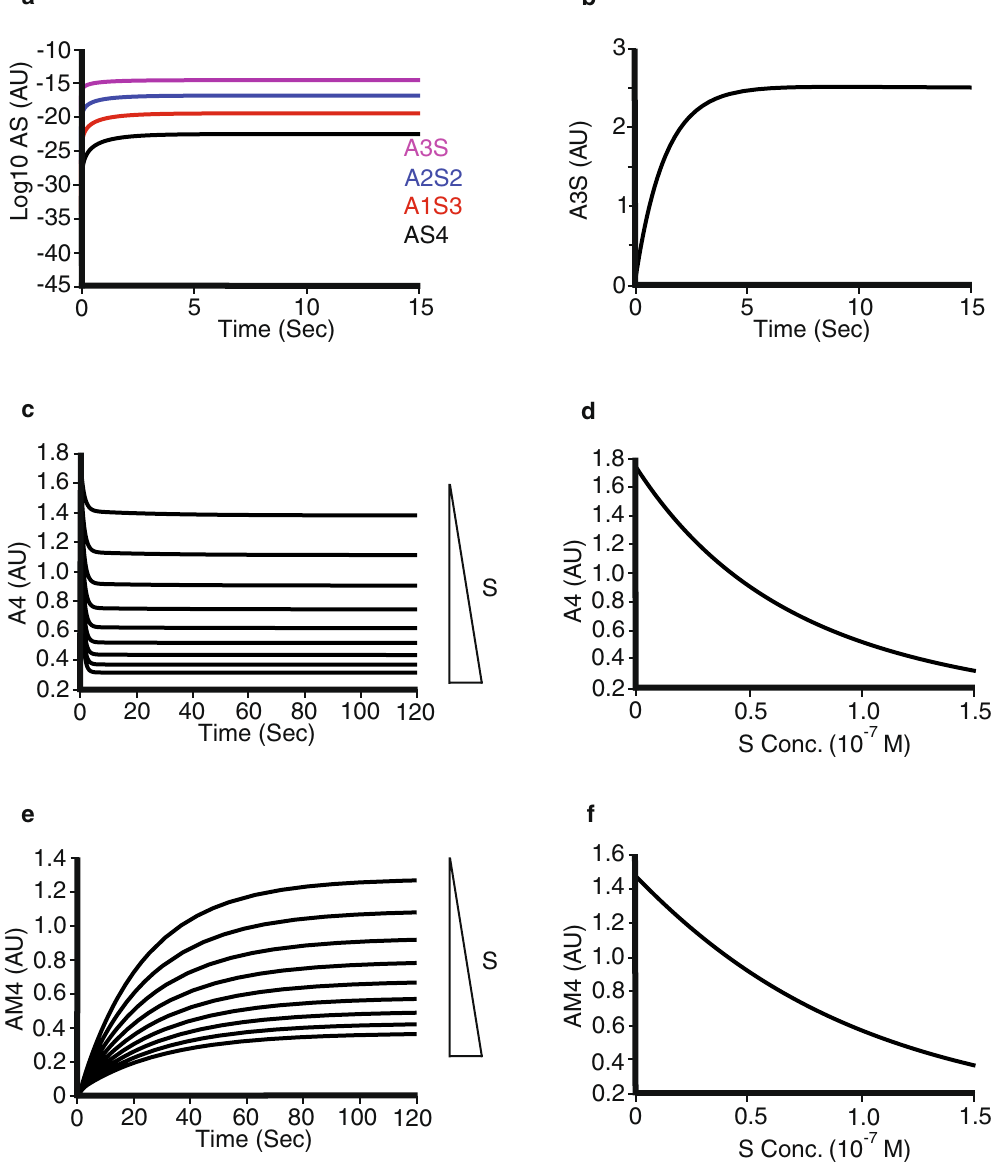
Figure 3. Numerical simulations of the effects of sTie2 on Ang1 binding. ( a ) Time course of formation of Ang1 bound to one (A3S; purple), two (A2S2; blue), three (A1S3; red) and four (AS4; black) soluble Tie2 ectodomains. Initial Ang1 concentration 0.18 nM, initial sTie2 concentration 1 nM. Amount of complex is shown in log scale (arbitrary units). ( b ) Time course of the formation of Ang1 complexed with a single sTie2 (A3S). ( c ) Time course of effects of different sTie2 concentrations up to 150 nM on free Ang1 (A4) concentration starting with a free Ang1 concentration of 0.18 nM ( d ) Concentration-dependence of sTie2 effects on free Ang1 (A4) concentration. ( e ) Time course of the effects of increasing sTie2 concentrations on the ability of 0.18 nM Ang1 to form the signalling-competent AM4 complex at the cell surface. ( f ) Concentration- dependence of sTie2 effects on formation of signalling-competent AM4 complex at the cell